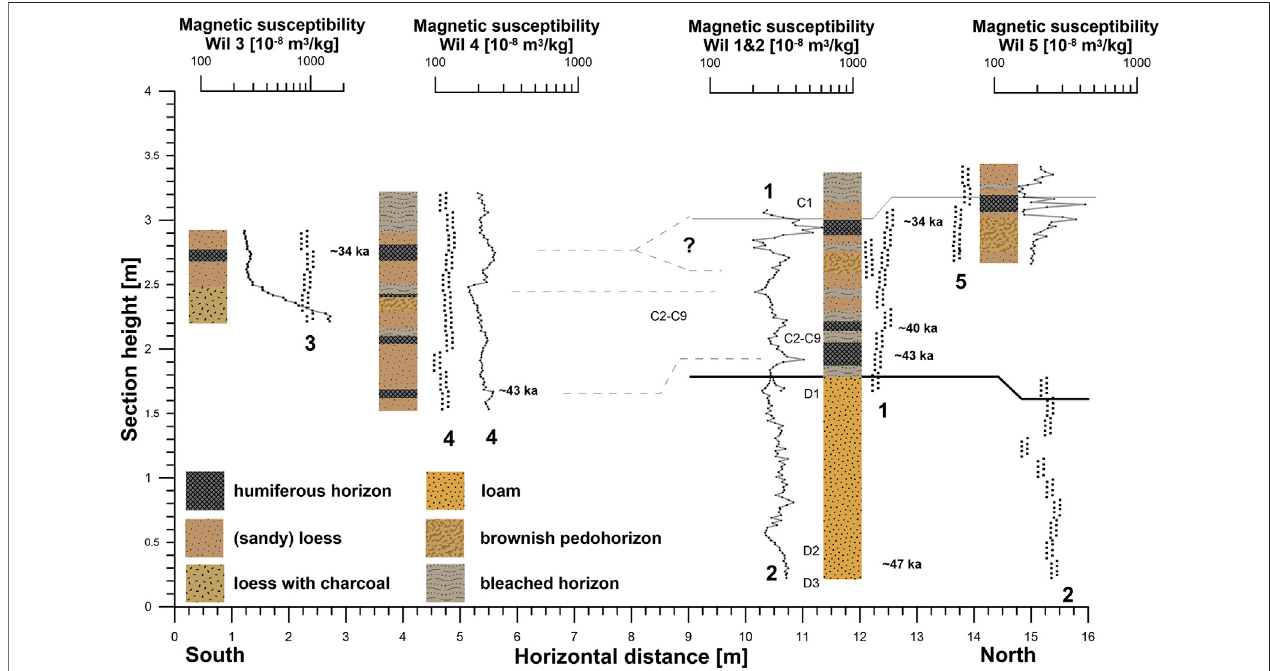
FIGURE2| SamplingschemeformagneticmeasurementsatWillendorfassamplingspurs.Themagneticsusceptibilitypro fi les(oneto fi ve,whereoneandtwoare plotted together) are plotted with simpli fi ed stratigraphies. Several geological layer numbers (from Nigst et al., 2008) are included here (C1-D3). Ages are taken from the correlation to Greenland ice core proxy data by (Nigst et al., 2014) and have been applied to equivalent depths of our pro fi les. Lines correlate different pro fi les (own interpretation).